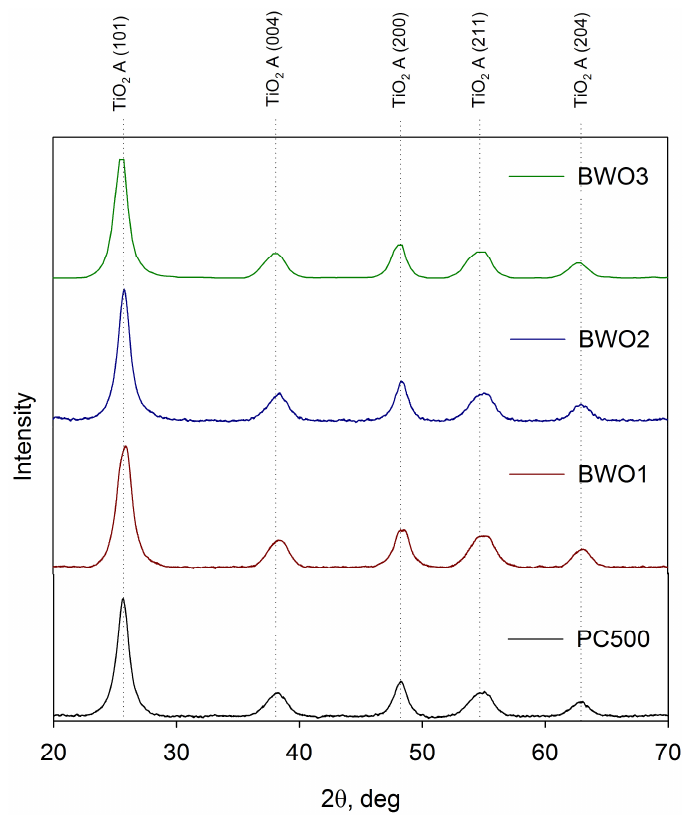
Figure 3. XRD spectra of bismuth tungsten oxide-coated and uncoated titania particles (anatase titania peaks marked as A).